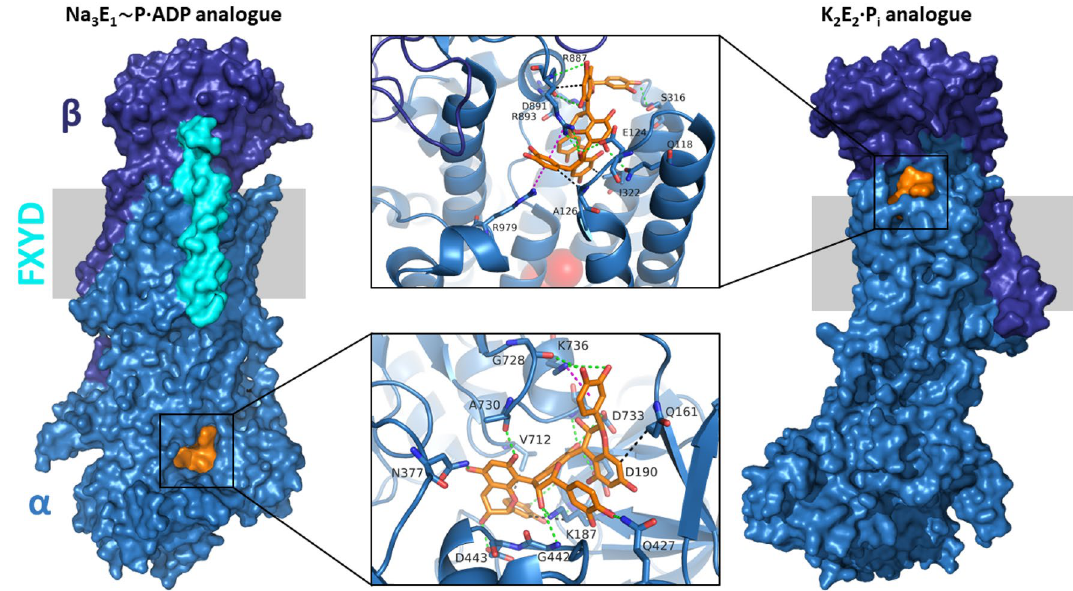
Figure 4. Binding modes of procyanidin C1 in the structures mimicking the Na 3 E 1 ∼ P·ADP state (left; 3WGU) and the K 2 E 2 ·P i state (right; 2ZXE). The membrane region is indicated by the grey area. Surface representation color code: subunit α—sky-blue; subunit β—deep blue; FXYD protein—cyan; procyanidin C1—orange. Non- covalent interactions are shown in the middle using the following color code: hydrophobic—black; hydrogen bonding—green; cation–π—magenta. Potassium ions are represented as red spheres. Figure was created using Avogadro (Avogadro: an open- source molecular builder and visualization tool. Version 1.2. http:// avoga dro. cc/; https:// doi. org/ 10. 1186/ 1758- 2946-4-